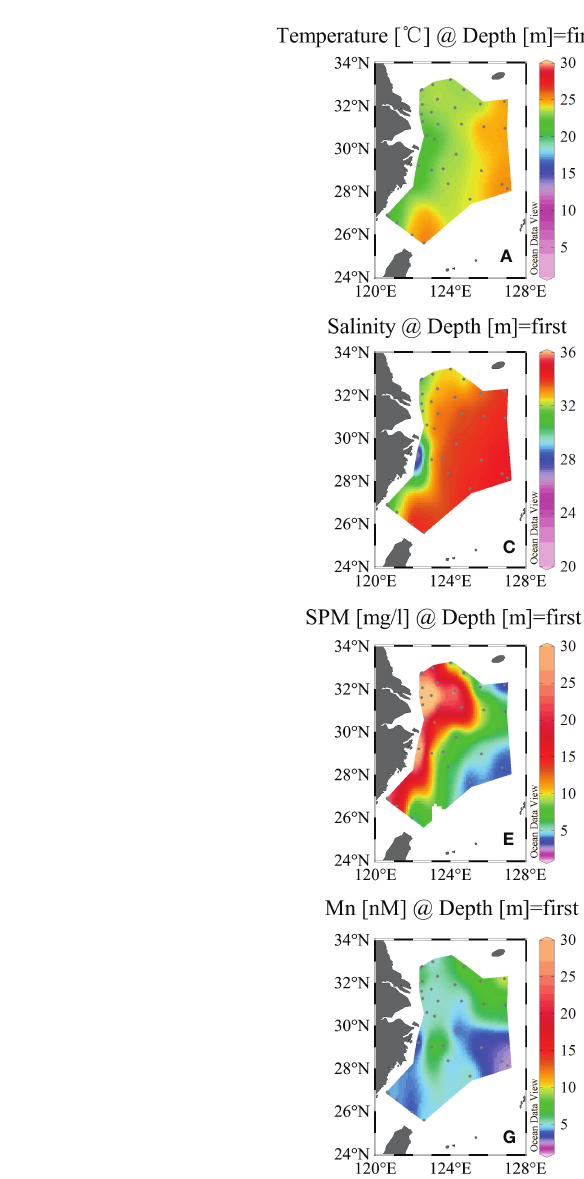
discharge of freshwater (Zhang et al., 2007). All samples during these cruises were divided into four subareas based on geographic locations (Figure 8): samples in the Changjiang plume, which show the Changjiang input into the ECS; samples in the inner shelf (depth < 50 m), which was strongly in fl uenced by terrestrial/bottom boundary inputs; samples in the outer shelf (50 m < depth < 200 m), which was in fl uenced by different water masses mixing; and samples in the Kuroshio mainstream water (depth > 200 m). The average concentrations of dissolved Mn in the Changjiang plume, inner shelf, outer shelf, and Kuroshio were (32.9 ± 25 nM), (15.4 ± 20 nM), (6.4 ± 2 nM) and (3.1 ± 1 nM), respectively. The highest concentrations of dissolved Mn were found in the Changjiang plume. The gradual decrease of dissolved Mn with distance re fl ects the contribution from the terrestrial input (Wang et al., 2016). The PN section from the